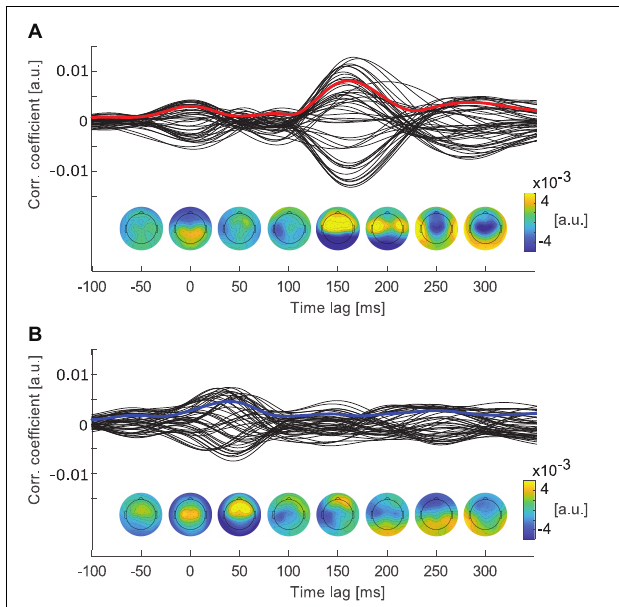
FIGURE 2 | Cross-correlation functions of each channel averaged over epochs and participants. Topographies below show the channel weights, indicating channels that contributed most to the correlations at time lags from − 50 to 300 ms in steps of 50 ms. (A) Cross-correlation functions of individual EEG channels with the attended speech envelope. The red line marks the global field power of the cross-correlation (GFP crosscorr ). (B) Cross-correlation functions of individual EEG channels with the ignored speech envelope. The blue line marks GFP crosscorr of the ignored speech